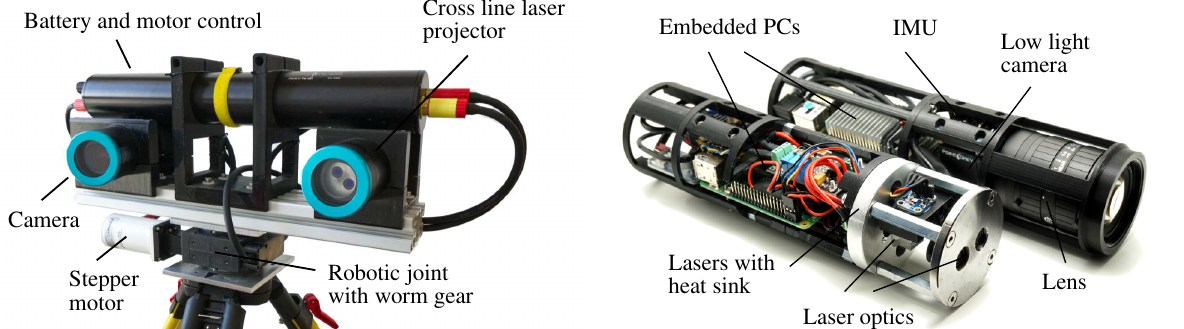
Figure 2. Structured light underwater laser scanner. Left: Scanner with motorized robotic joint mounted on a tripod, right: Detail view of the camera and laser projector assemblies mounted inside the underwater housings. ner and measuring the movement using rotational encoders or mounting the scanner to a moving